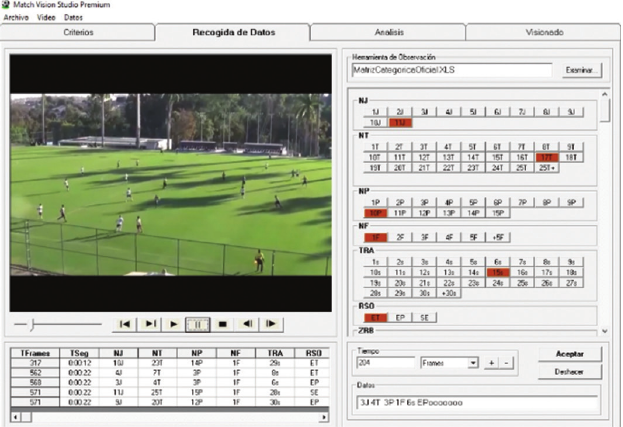
Figure 1. Screen capture from Match Vision Studio Premium ® software with the categorical matrix used in the study.